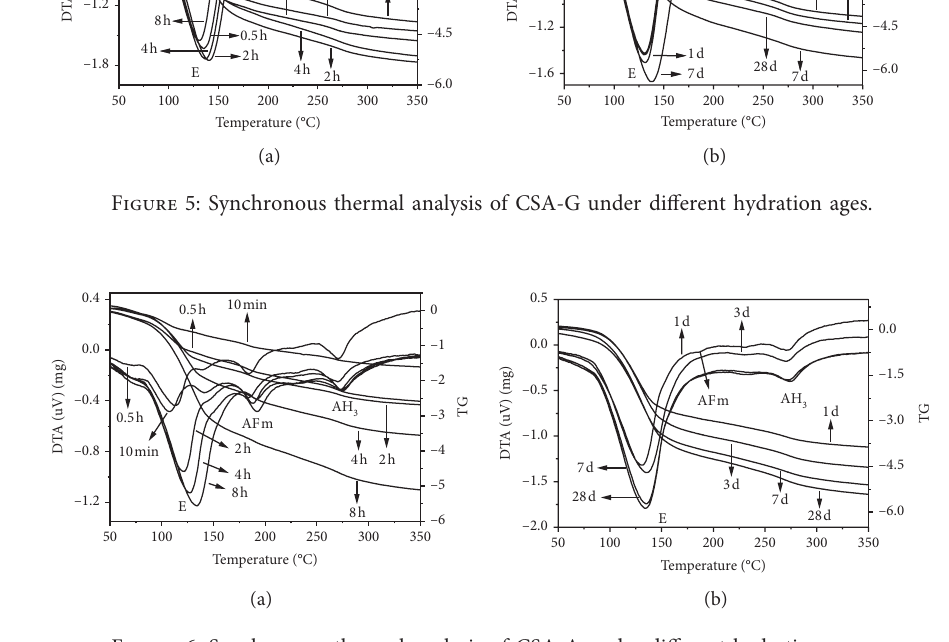
Figure 6: Synchronous thermal analysis of CSA-A under different hydration ages.